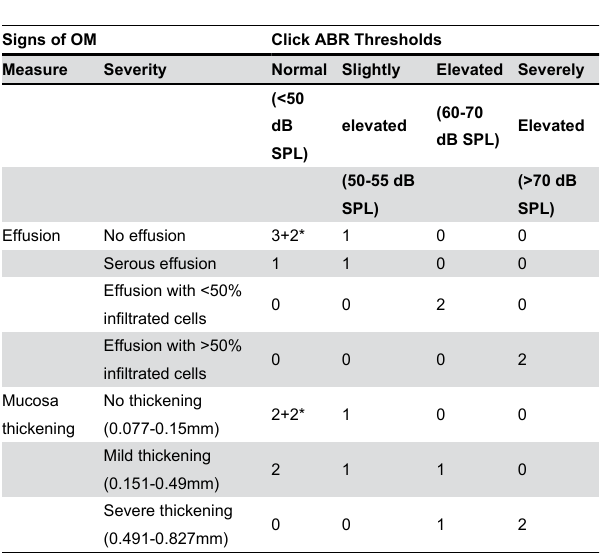
Table 1. Correlation between severity of OM and click ABR thresholds in ears from six littermates (5 Df1/+ , 1